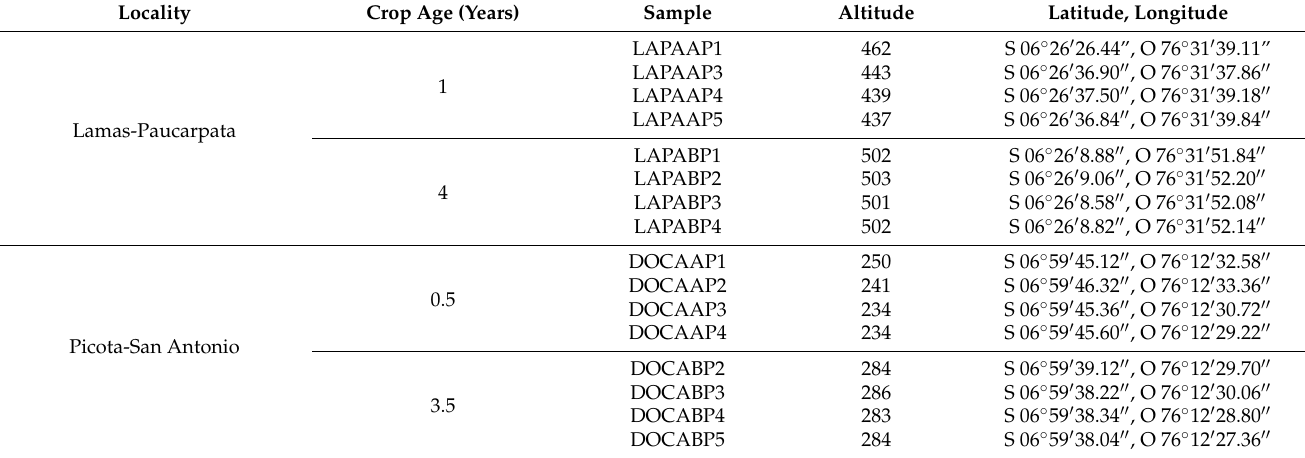
Figure A2. Rarefaction analysis of the composition of operational taxonomic units (OTUs) of arbus- cular mycorrhizal communities forming the gene library. Extrapolated value of the curve predicted a total of 16 OTUs when 1000 clones would be analyzed. Table A1. Sampling site